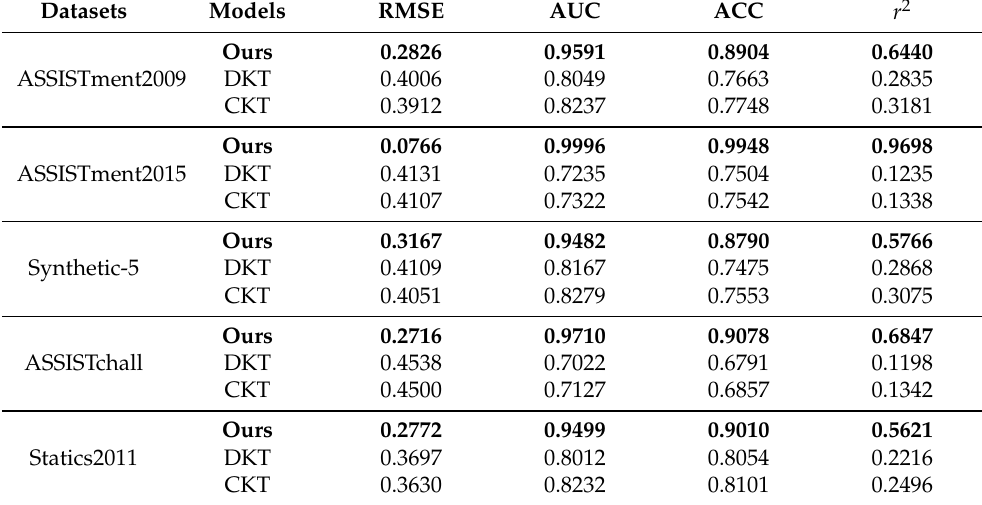
Table 5. Comparison of experimentation results among DKT-STDRL, DKT, and CKT